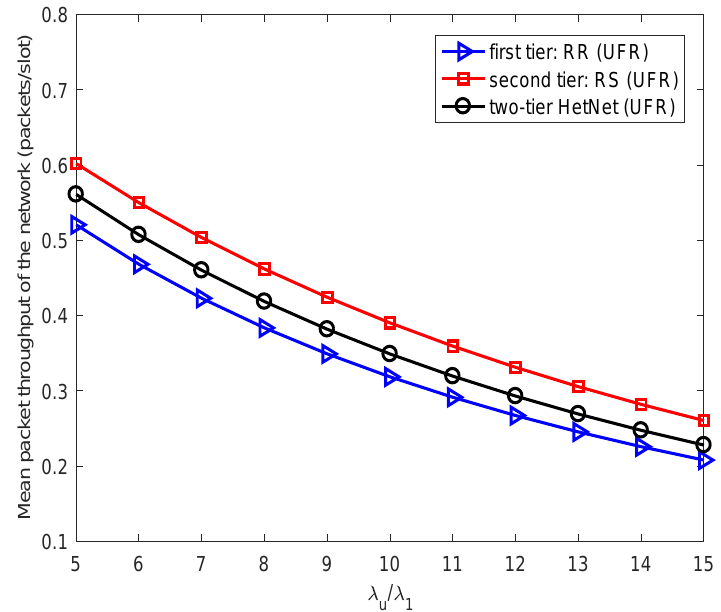
Figure 3. The mean packet throughputs of the network versus λ u / λ 1 . b 1 = 1, b 2 =